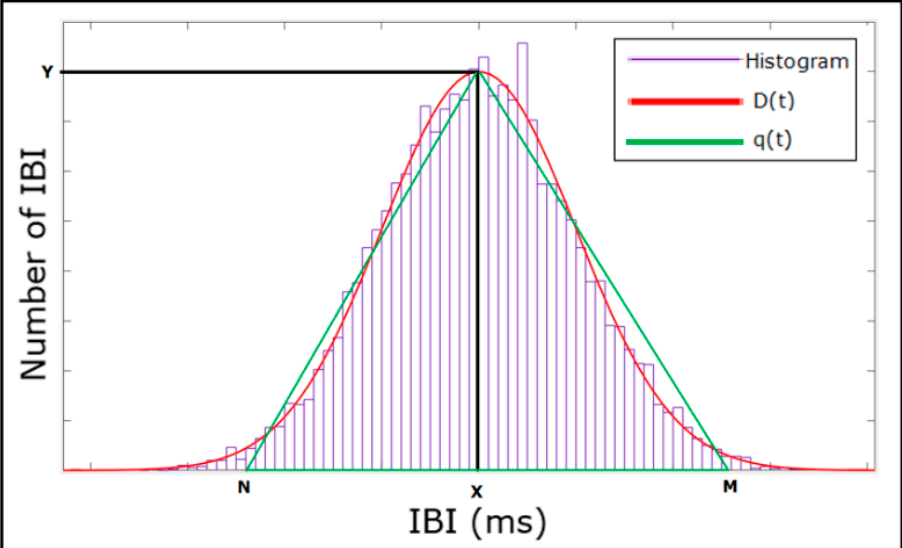
Figure 4. Histogram of a typical IBI time series. D(t) is a density distribution of IBI and q(t) is the triangular function fitted to D(t). Y is the maximum value of D(t), where t = x, and M and N are the other two vertices of the triangular function.